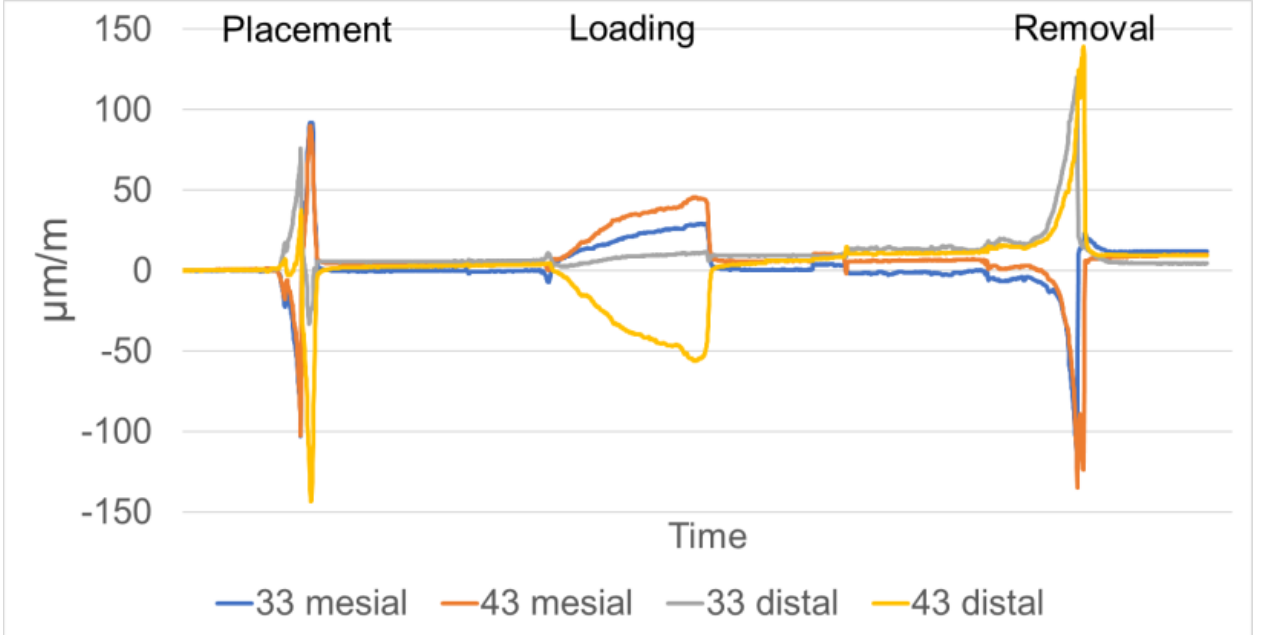
Figure 4. Measurement procedure. ( a ) Following placement of the prosthesis, masticatory static loading with 50 N was performed in the area of the second premolar/first molar; ( b ) As a final step, the prostheses were removed from the jaw model by applying axial force via wires.